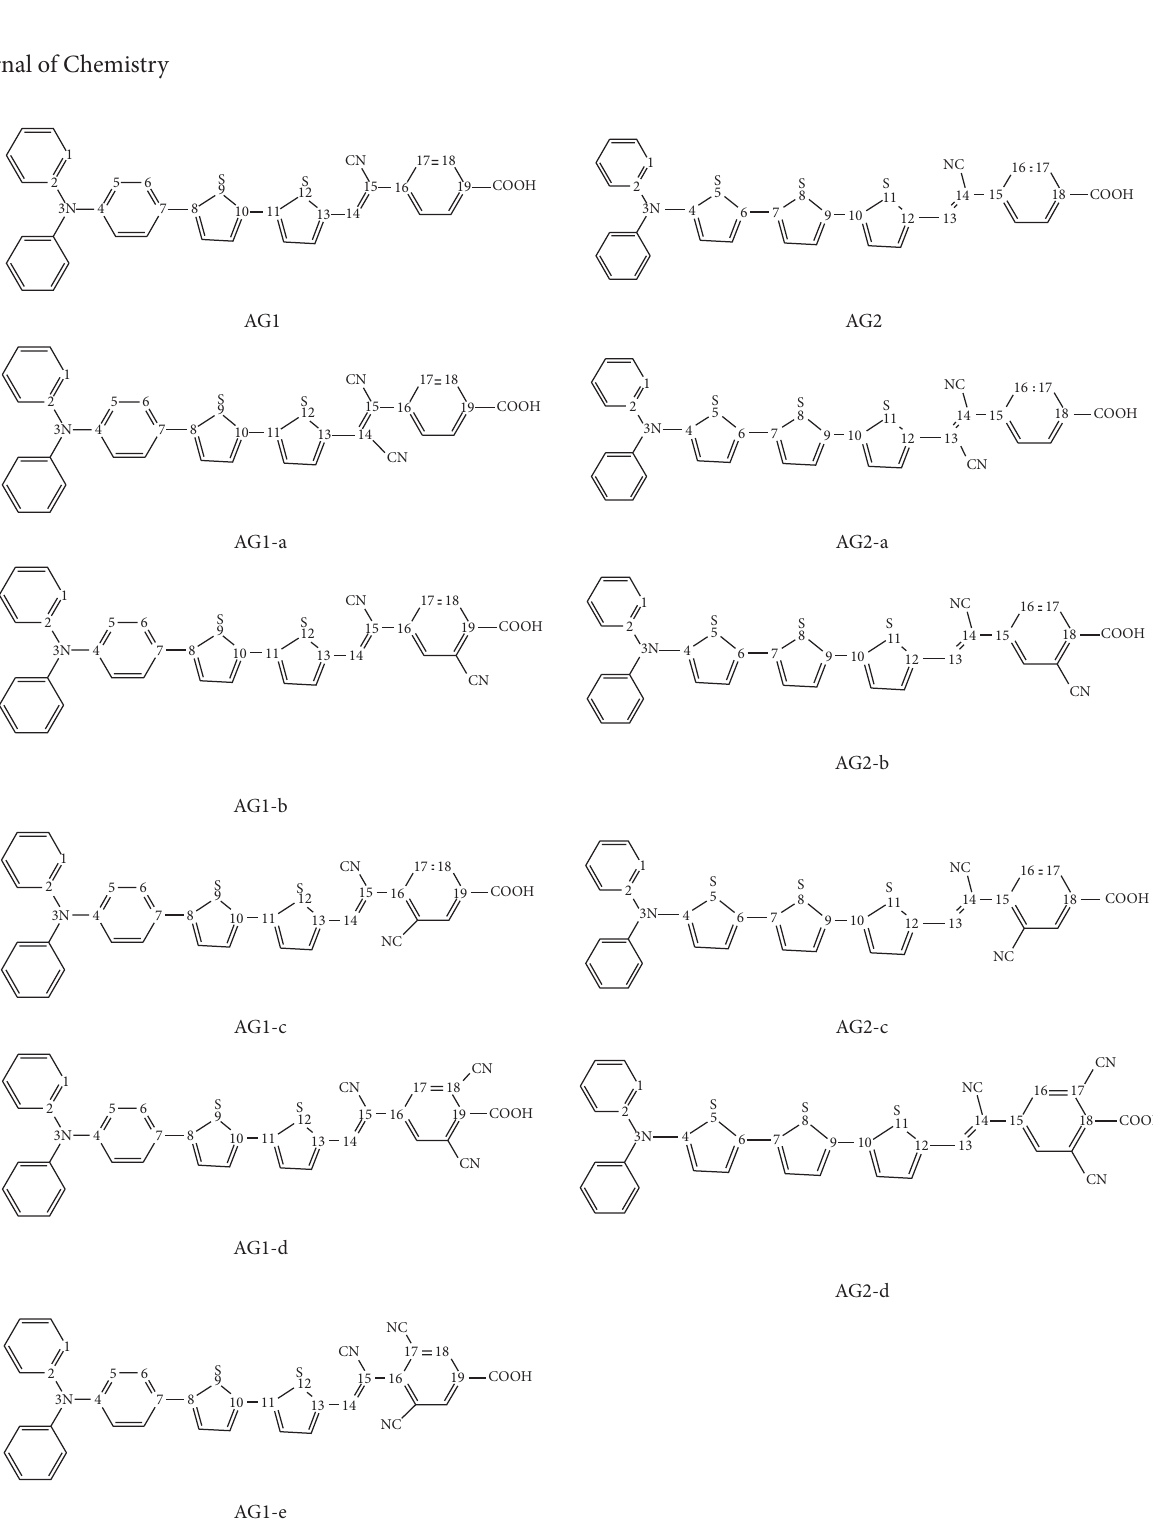
Figure 1: Chemical structures of two molecules AG1 and AG2 and designed nine molecules (AG1, AG1-a, AG1-b, AG1-c, AG1-d, AG1-e, AG2, AG2-a, AG2-b, G2-c, and